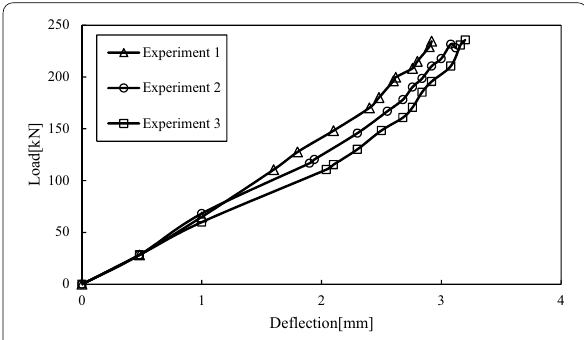
Fig. 20 Load–deflection diagram of the sleeper-included negative bending moment of the rail